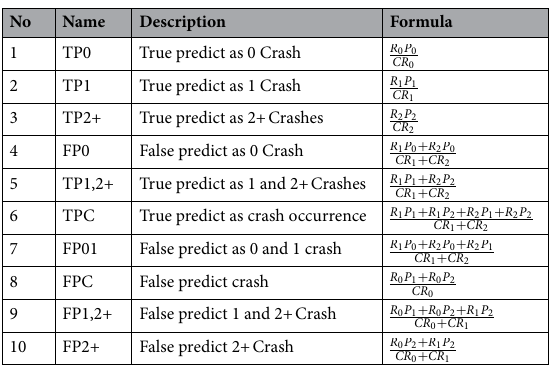
Table 4. Evaluating measures computed from elements of confusion matrix to compare the accuracy of crash frequency prediction